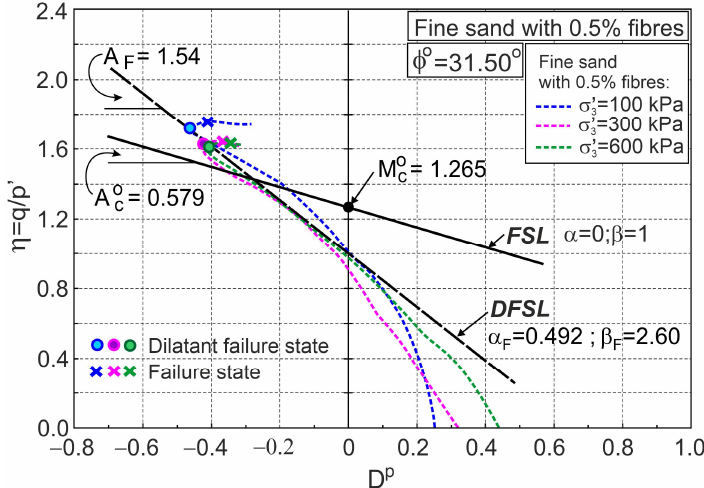
Figure 6. Stress ratio–plastic dilatancy relationships for sand with 0.5% fibres (based on the experi- mental data from [5]).